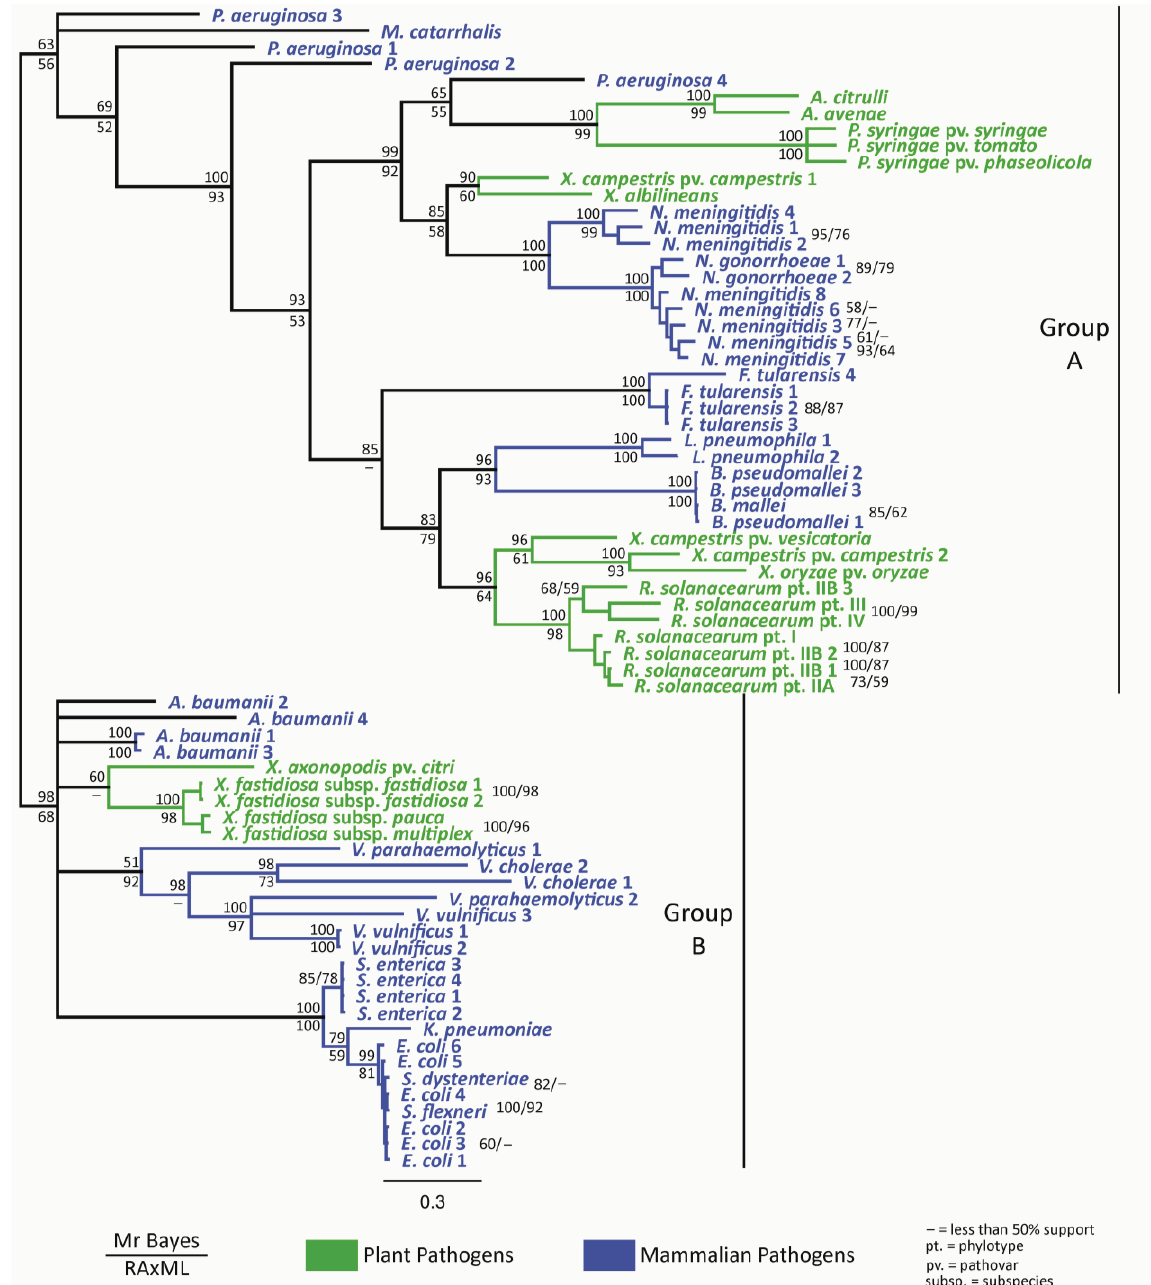
Figure 2. Phylogeny of the unique pilA (pilin) DNA sequences (n = 71) found among the complete genomes of plant and mammalian bacterial pathogens deposited in GenBank (Table S1, supplementary material) as inferred by Bayesian phylogenetic (BP) analyses. Nodes with <50% support were collapsed. BP posterior probabilities and maximum likelihood (ML) bootstrap values are presented above and below each node, respectively. Dashes indicate relationships not supported based on ML analyses. Group A contains bacteria with type IVa pili and Group B contains bacteria with type IVb pili. Plant pathogens are in green, and mammalian pathogens are in